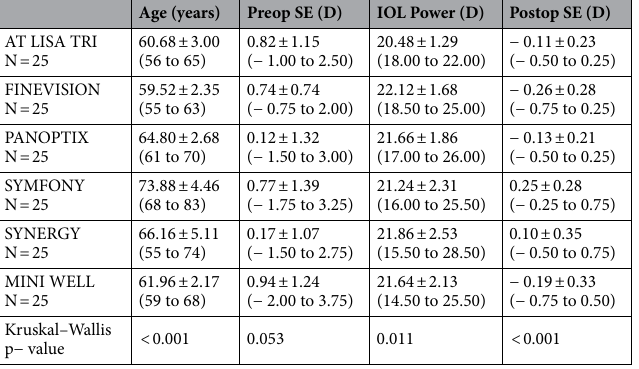
Table 1. Characterization in terms of age, preoperative and postoperative spherical equivalent (SE), and intraocular lens (IOL) power of the six IOL subgroups analyzed in the current study.